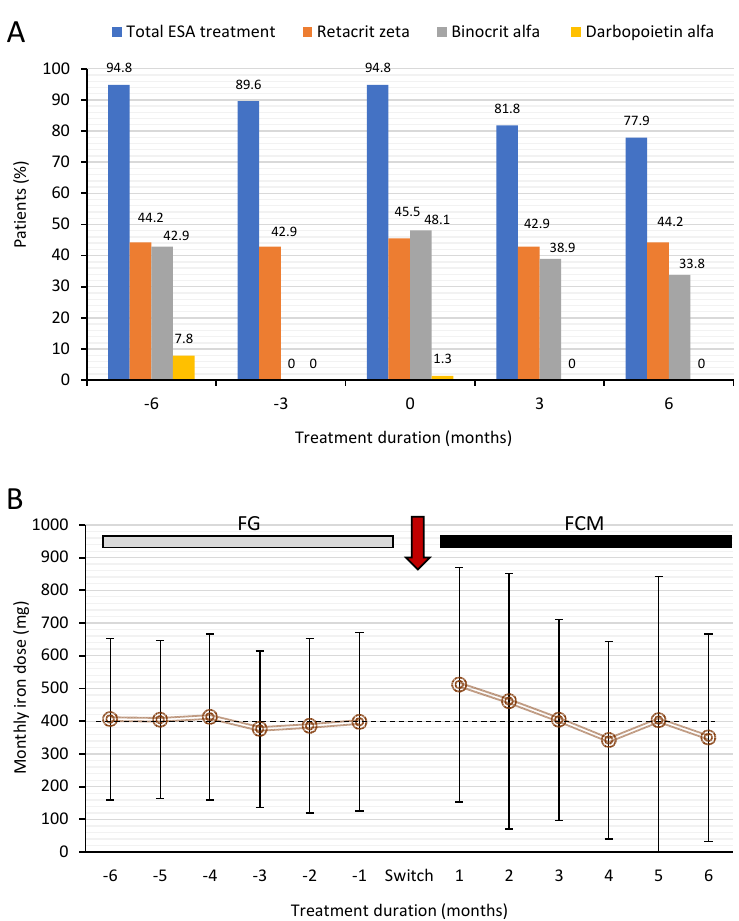
Figure 1. Treatment with ESA and iron in hemodialysis patients who switched from FG to FCM. ( A ), the proportion of patients (%) treated with different ESAs during FG and FCM treatments over the 12 months; ( B ), monthly iron dose in patients during FG and FCM treatments over the 12 months. The dotted line represents iron dose at the pre-switch visit ( − 1 months). Monthly iron dose data are presented as mean ± SD whereas. FCM = ferric carboxymaltose, FG = ferric